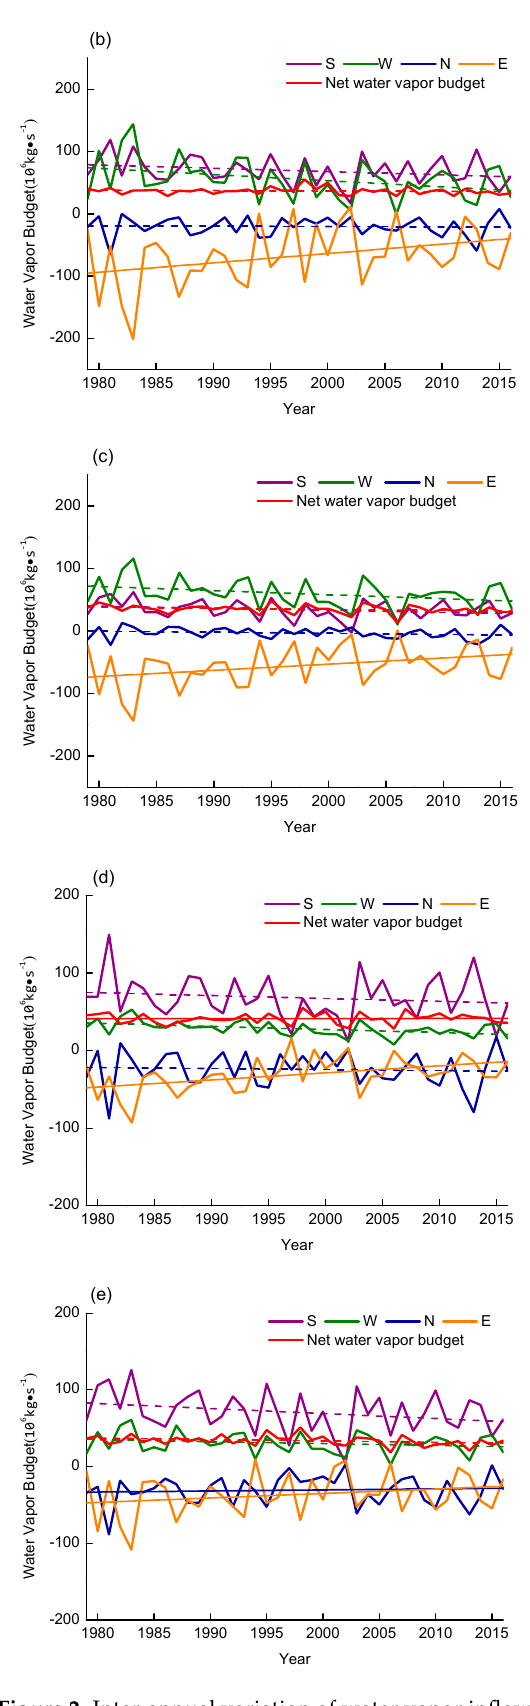
Figure 2. Inter-annual variation of water vapor inflow and outflow and net water vapor budget